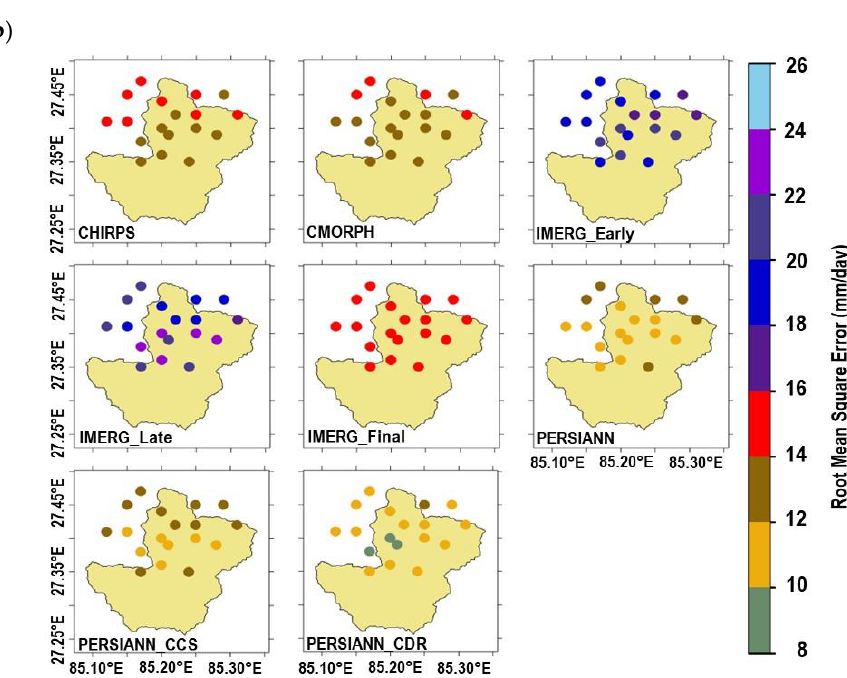
Figure 3. Spatial variation in the performance of all datasets in terms of POD ( a ) and RMSE ( b ) correspondence to each rain gauge station of Simat Khola River Basin from 2003 to 2018.